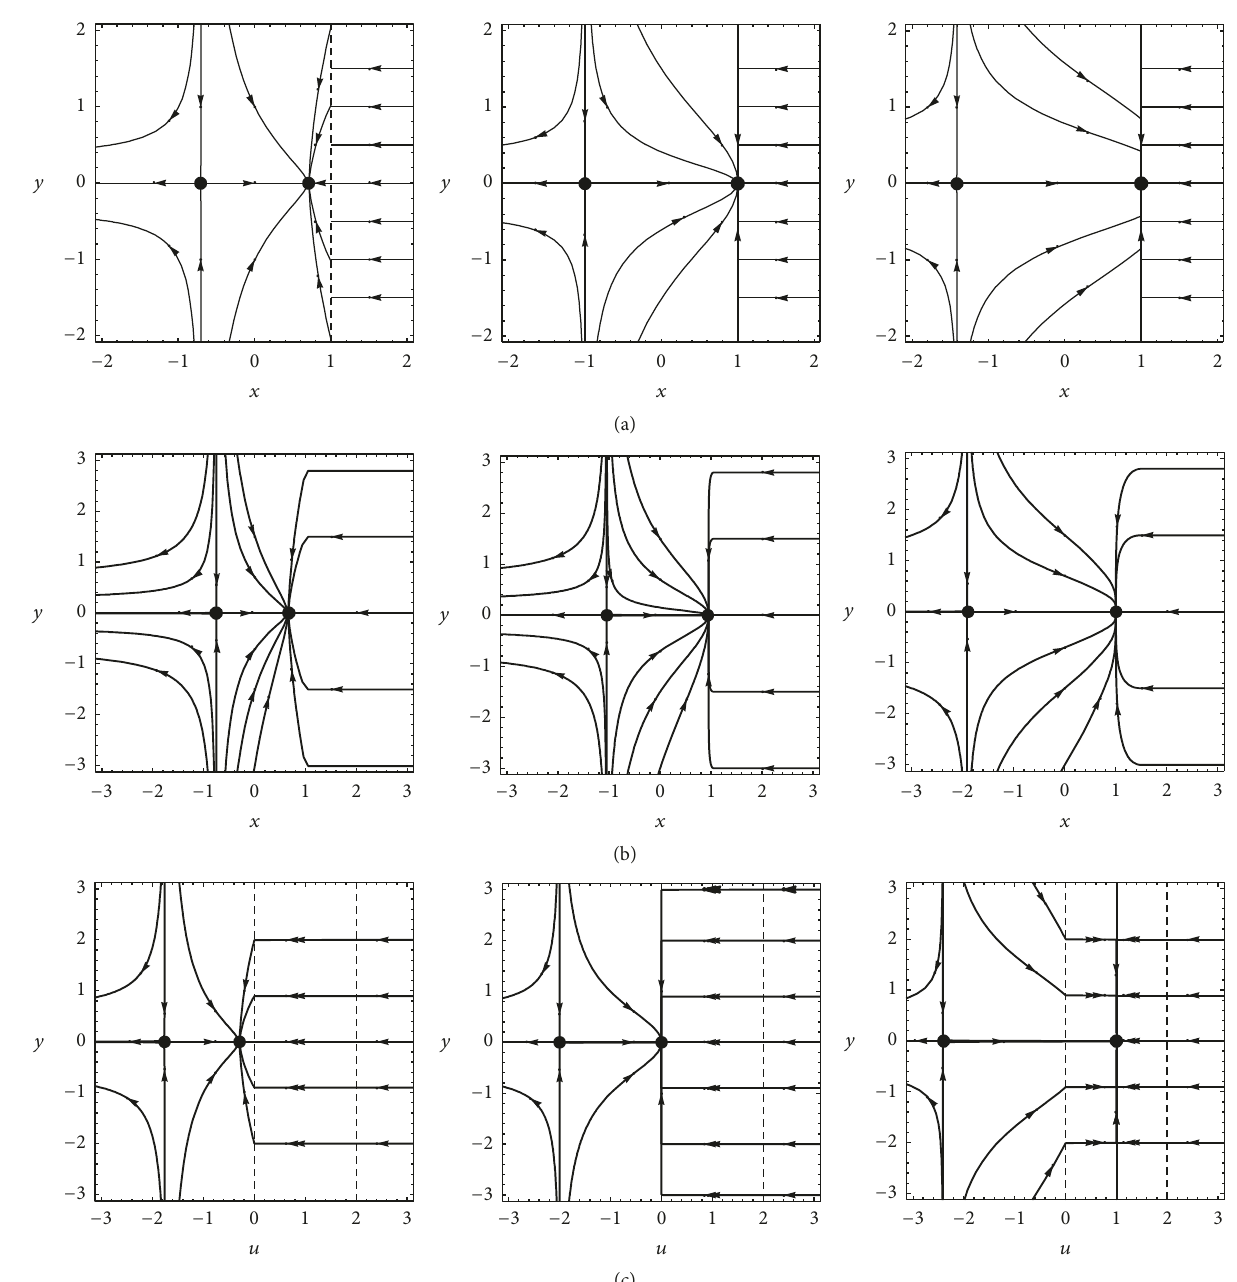
Figure 4: (a) Equilibrium transition between an ordinary node and a pseudonode. (b) The corresponding regularization. (c) The corresponding slow-fast flow.